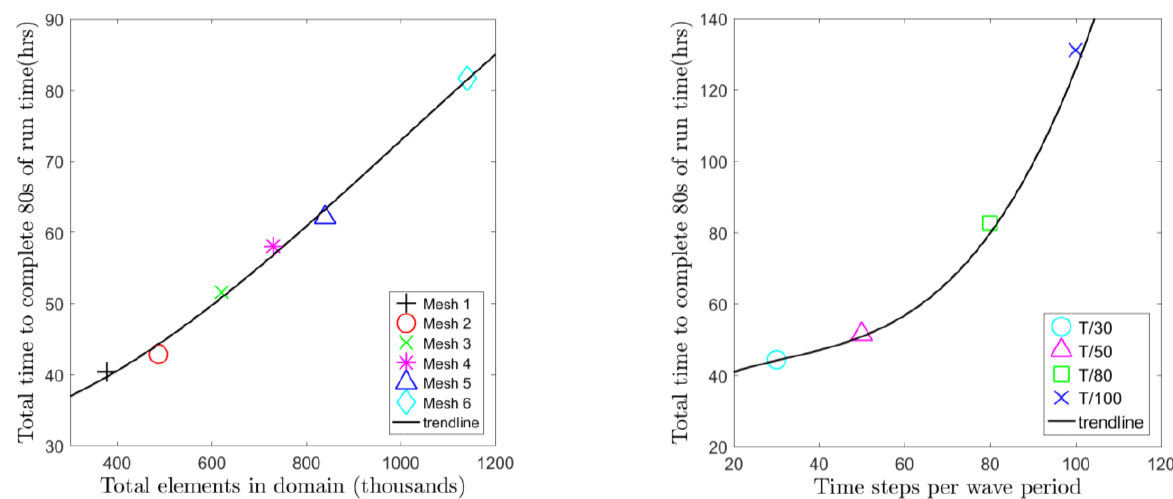
Figure 8. Computational speed of numerical model with different time steps.